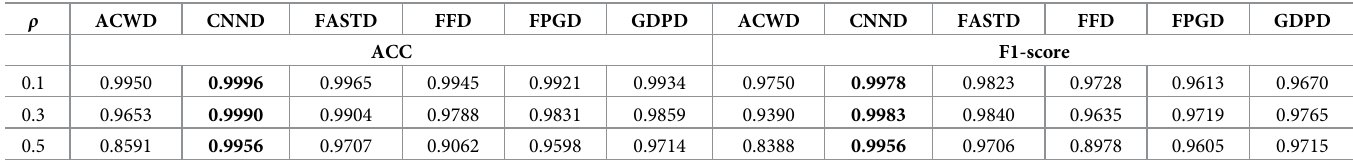
Table 3. Medians of ACC and F1-score obtained using different detectors.